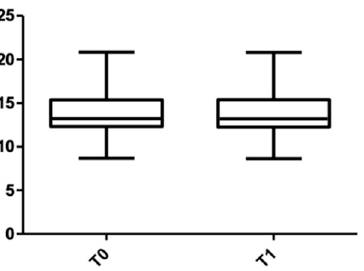
Figure 11. Root length distribution in the upper arch at T0 and T1.